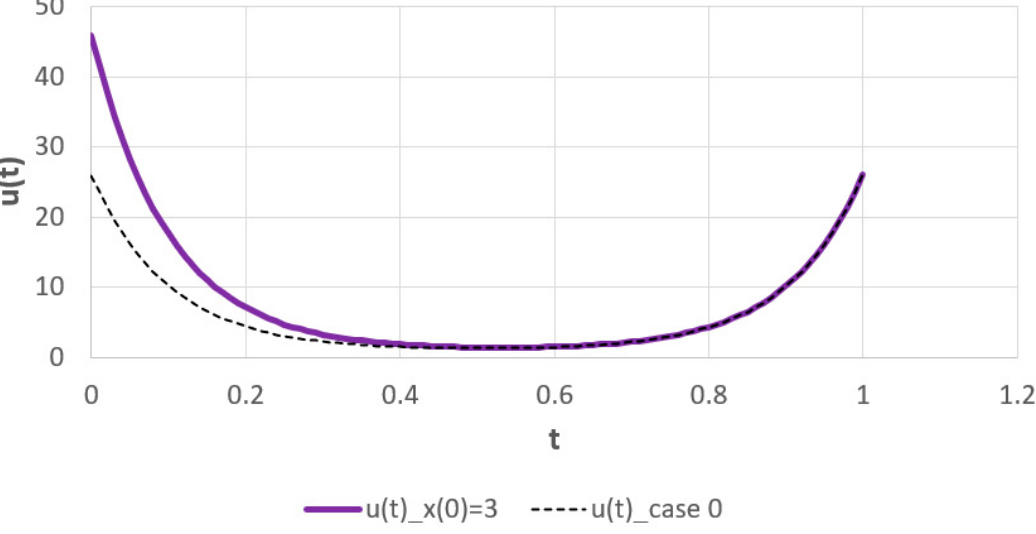
Figure 13. The optimal time path of u in Dynamic case 1.